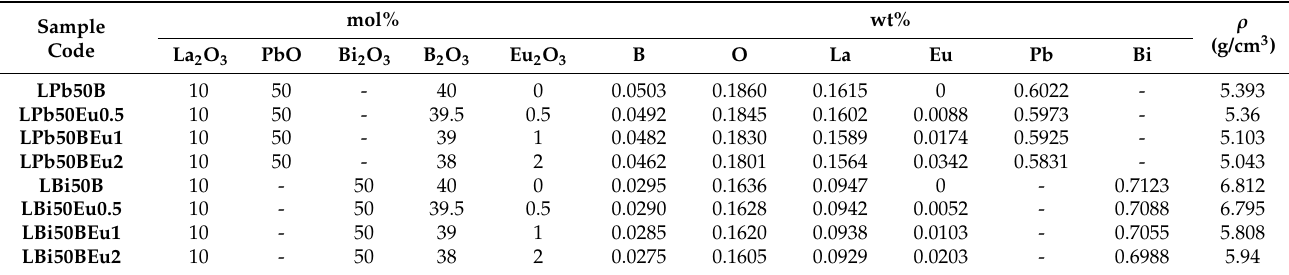
Table 1. Chemical compositions and density for glass